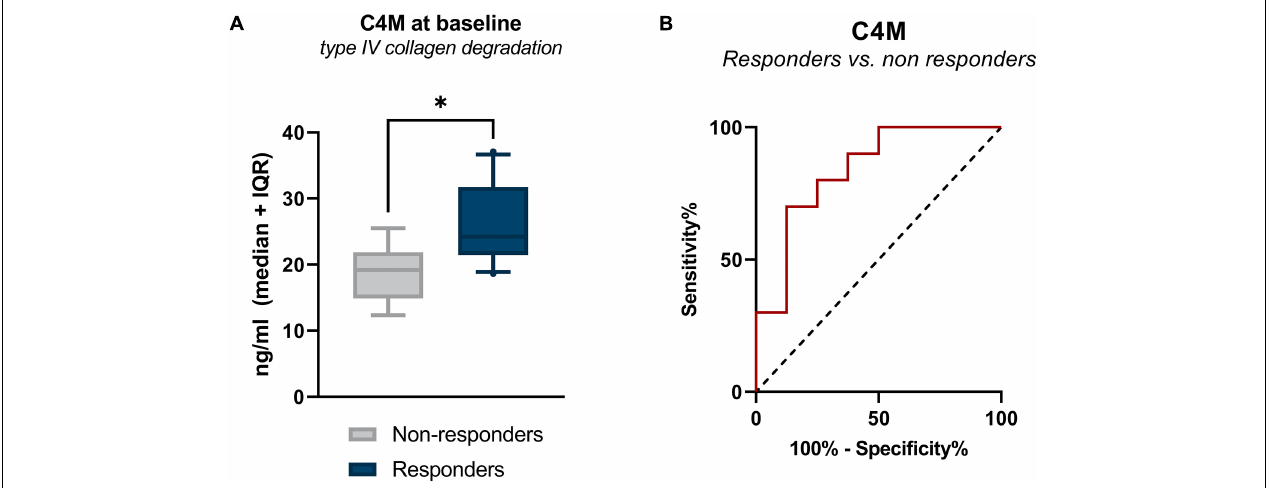
FIGURE 1 | (A) Serum levels of C4M in CD patients with surgical history, stratified by response to IFX treatment. Baseline levels of type IV collagen degradation (C4M) were elevated in responders compared with non-responders ( P < 0.05). (B) Receiver operating characteristic curve showing the discriminative power of C4M at baseline to differentiate between responders and non-responders at week 14 ( P = 0.016). * P < 0.05.